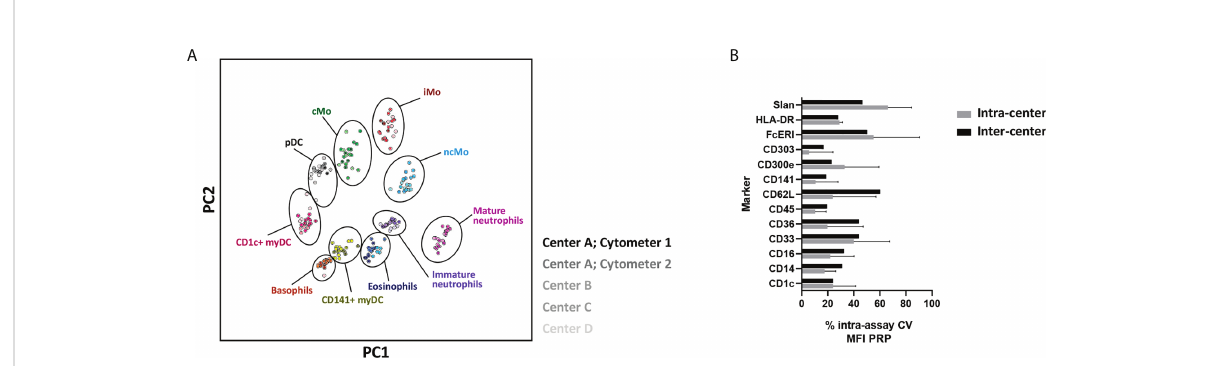
FIGURE 8 Performance of the EuroFlow immunemonitoring innate myeloid cell (IMC) tube in a multicentric setting. (A) Principal component analysis (PCA) plot depicting the staining pro fi le of 21 healthy adult peripheral blood samples processed at 4 centers and measured in 5 different instruments, employing the 11-color version (version 3) of the EuroFlow innate myeloid cell tube. Solid circles, represent the median values of the populations and the shades of color represent different centers and/or instruments. (B) depicts the intra-assay % of coef fi cient of variation for individual markers within centers (intra-center; biological variation) and between centers (inter-center, technical variation). cMo, classical monocytes; iMo, intermediate monocytes; ncMo, non-classical monocytes; pDC, plasmacytoid dendritic cells; myDC, myeloid dendritic cells; PC, principal component; CV, coef fi cient of variation; MFI PRP, Median Fluorescence Intensity of Positive Reference